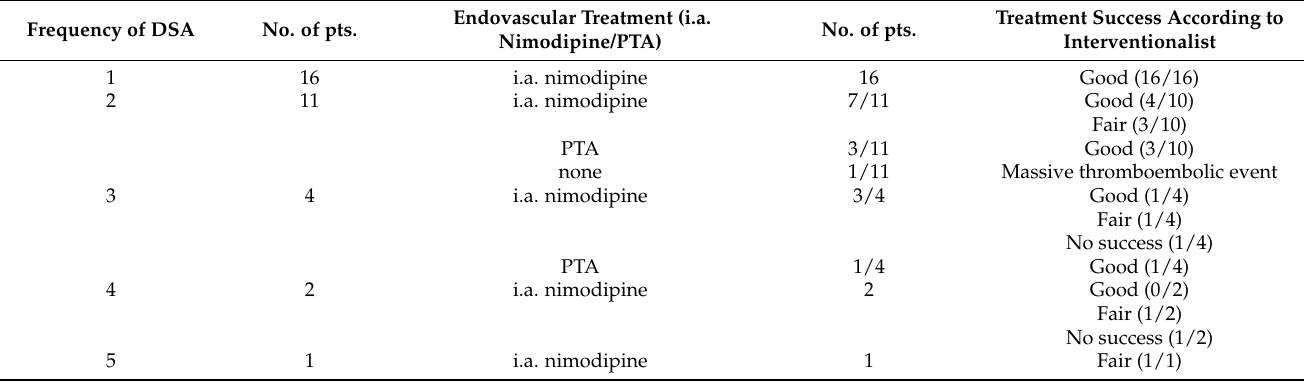
Table 2. Invasive endovascular treatment.